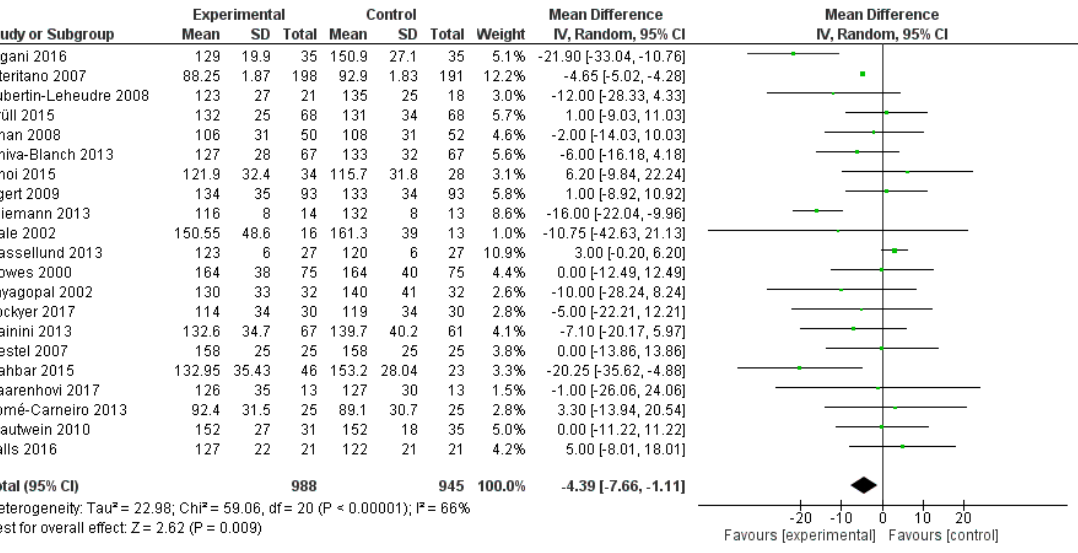
Figure 4. Pooled analysis of association between polyphenol intake and high-density lipoprotein cholesterol (HDL-C).